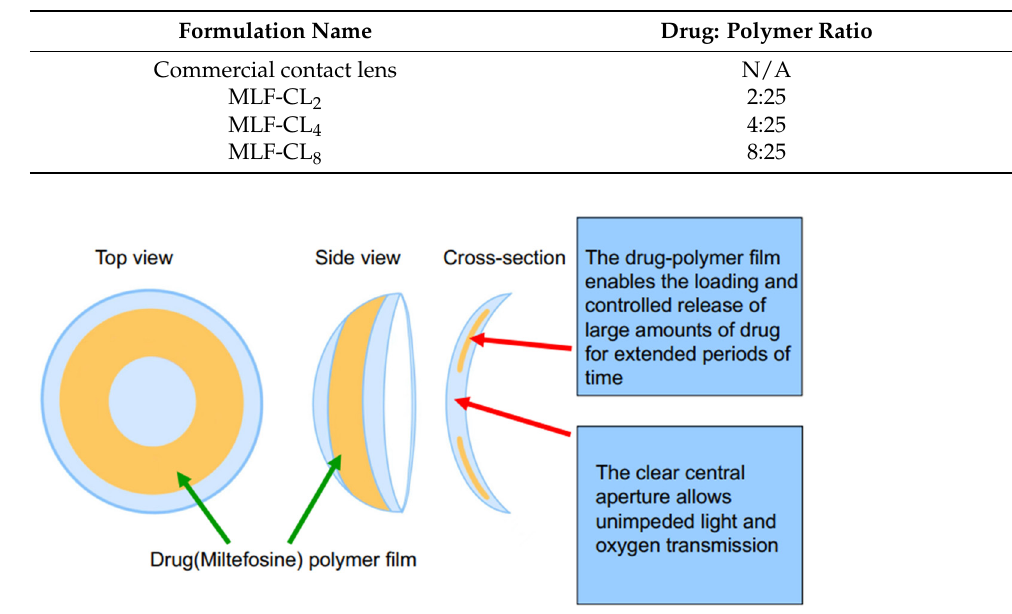
Table 1. MLF-CL formulations. Formulation Name Drug: Polymer